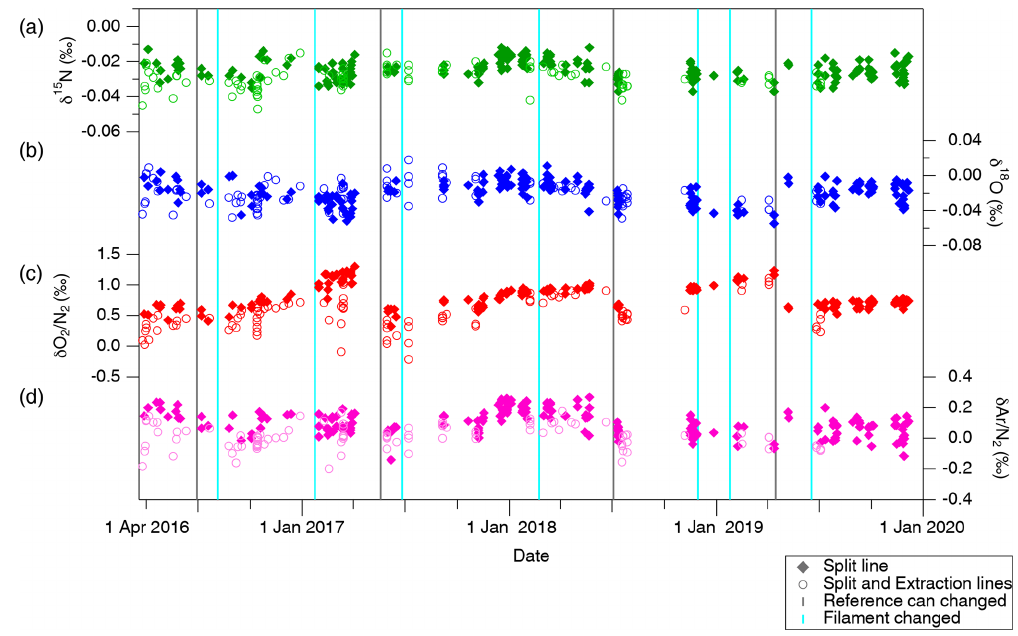
Figure 6. Standard gas (STD-A) composition measured against reference gas for (a) δ 15 N, (b) δ 18 O, (c) δ O 2 / N 2 and (d) δ Ar / N 2 . Filled markers represent samples transferred only through the split line, and open markers represent samples transferred through both extraction and split lines. Vertical grey lines indicate the timing of replacements of the reference can, and vertical light blue lines indicate the timing of filament